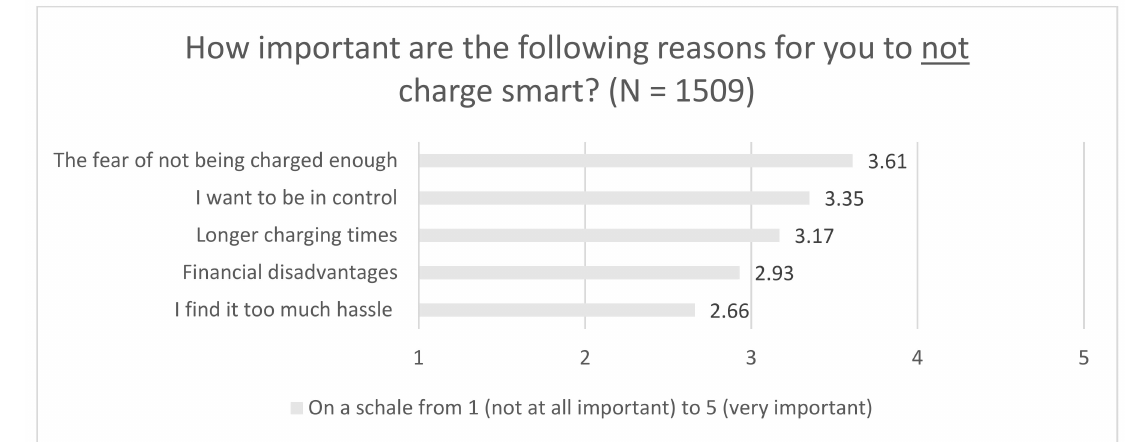
Figure 4. Reasons not to charge